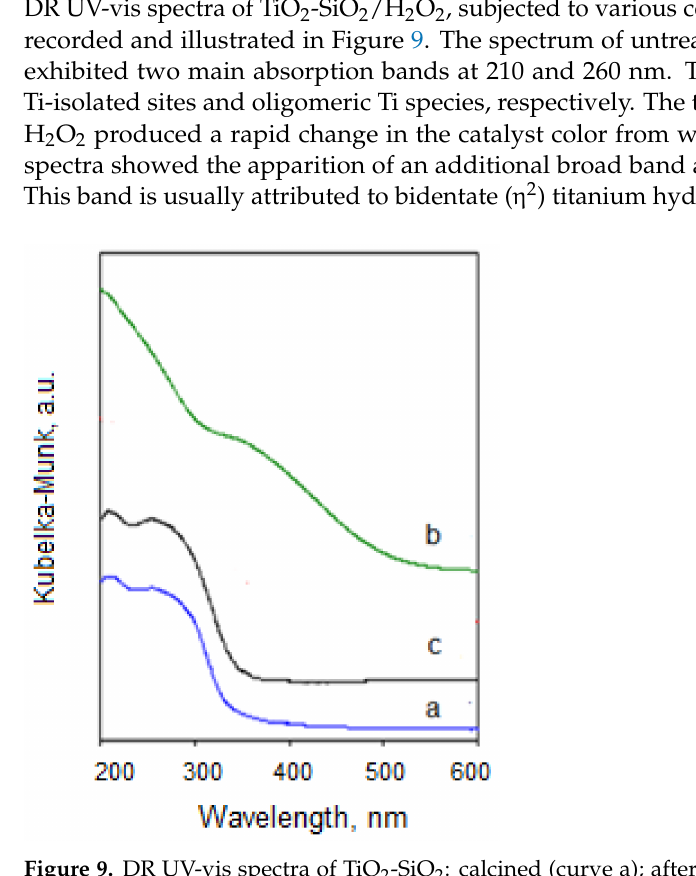
Figure 9. DR UV-vis spectra of TiO 2 -SiO 2 : calcined (curve a); after adsorption of H 2 O 2 (curve b); then followed by thermal activation in air at 550 ◦ C (curve c). Adapted from ref. [86], used with permission. Copyright 2010